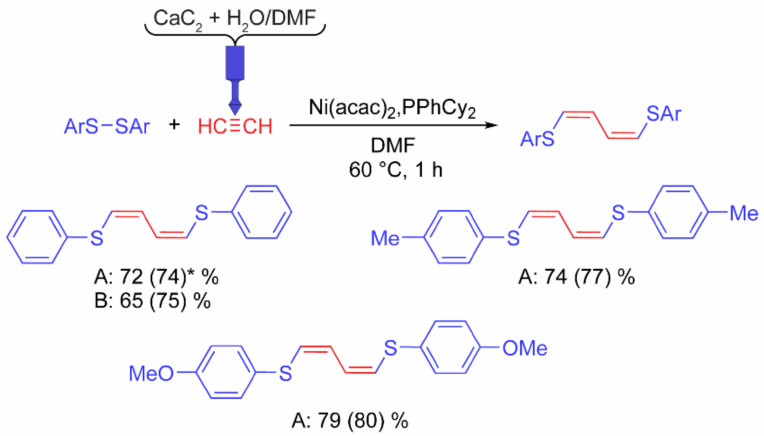
Figure 7. Scope of 1,4-bis(arylthio)buta-1,3-diene synthesis using the designed reactor (A) and acetylene from a gas cylinder (B). * NMR yields in